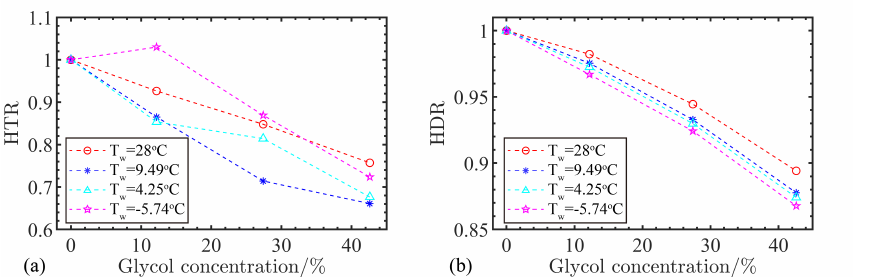
Figure 8. Plots of the HTRs and HDRs for different glycol concentrations. ( a ) Plots of HTRs. ( b ) Plots of HDRs.